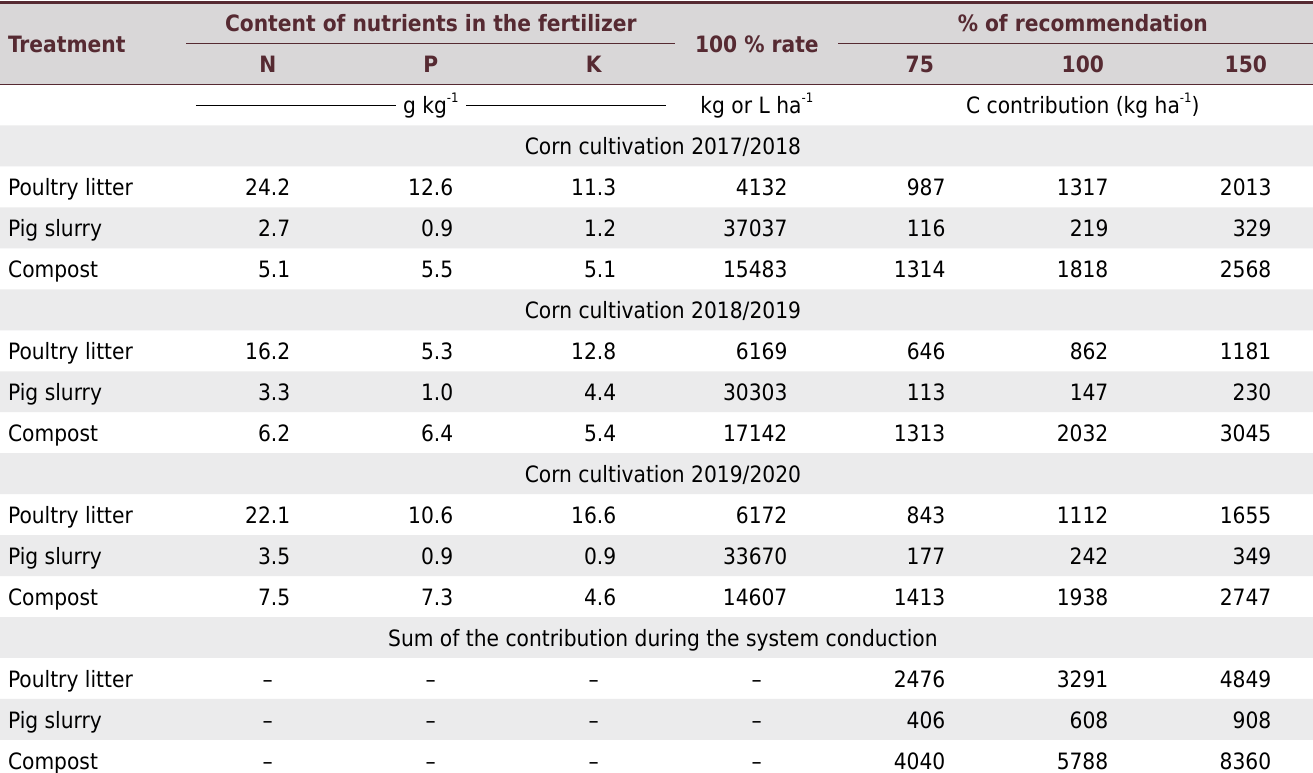
Table 2. Nutritional report of organic fertilizers in integrated crop-livestock Content of nutrients in the Treatment